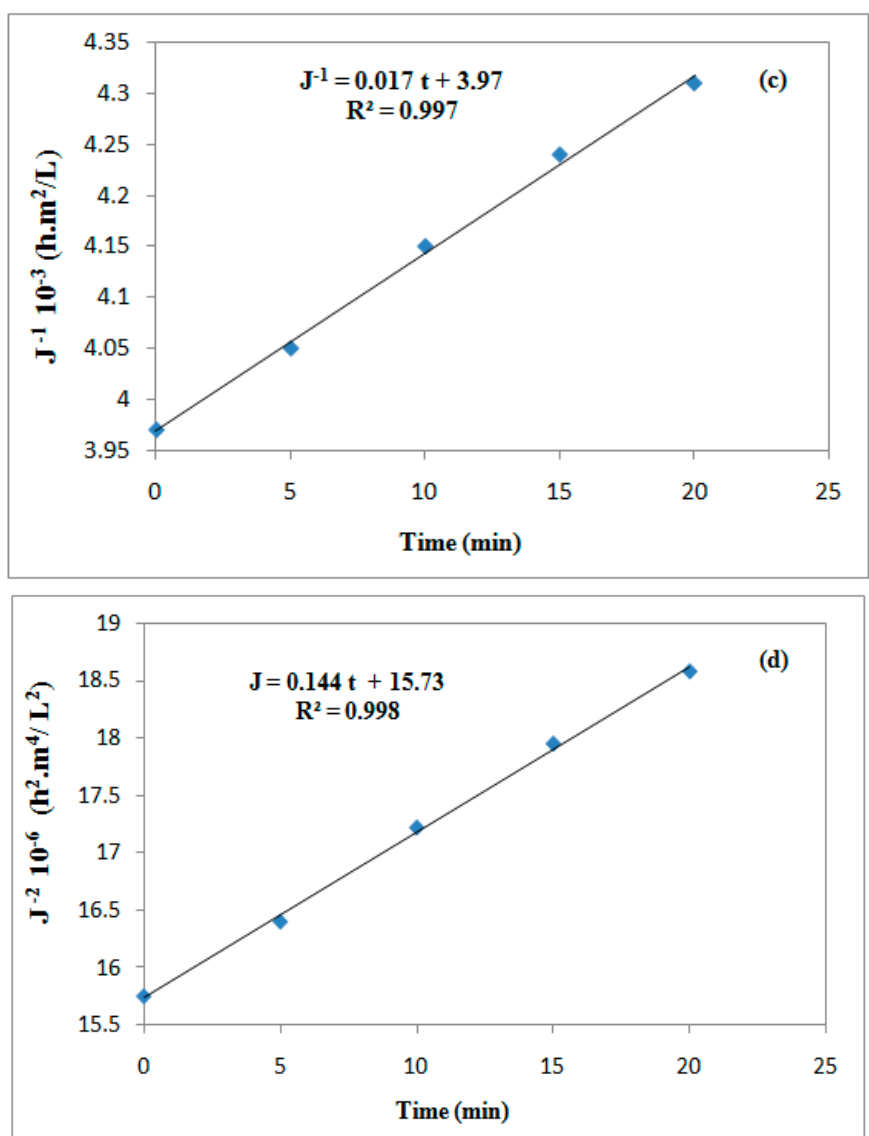
Figure 10. Linearized models of permeate fluxes of wastewater using a UF TiO 2 membrane: complete pore blocking ( a ), standard pore blocking ( b ), intermediate pore blocking ( c ), and cake filtration ( d ).